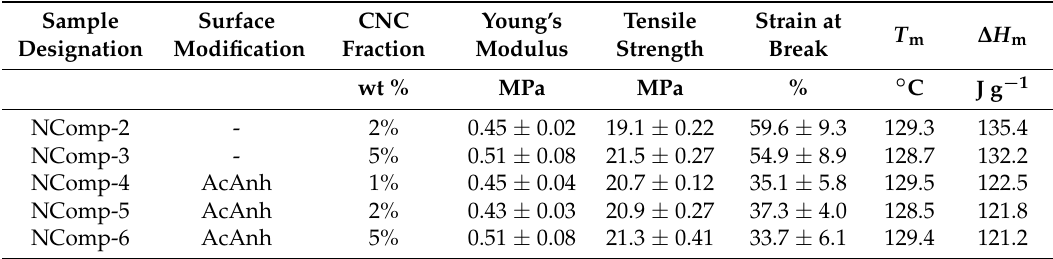
Table 1. Mechanical and thermal properties of CNC/LLDPE (linear low-density poly(ethylene)) nanocomposites as a function of CNC weight fraction and surface modification.